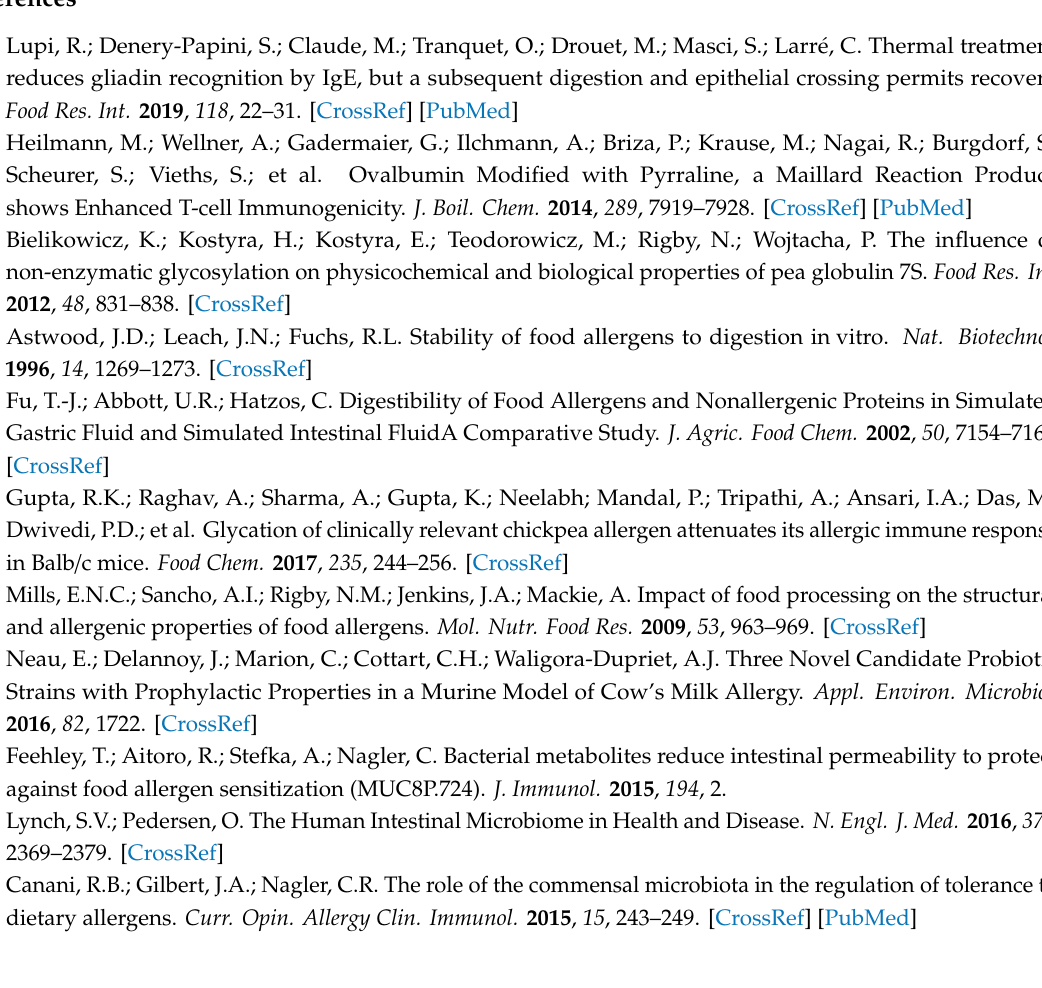
Figure S1: Schematic diagram of mouse sensitization model. Figure S2. Solubility of native glutenin, heated glutenin, and heated MGO-glutenin